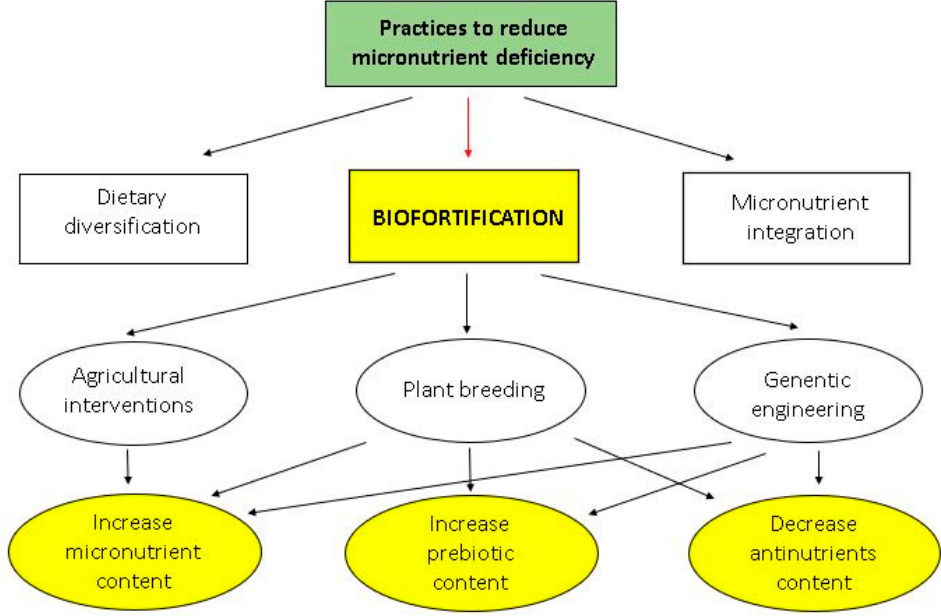
Figure 1. Biofortification tools and results.